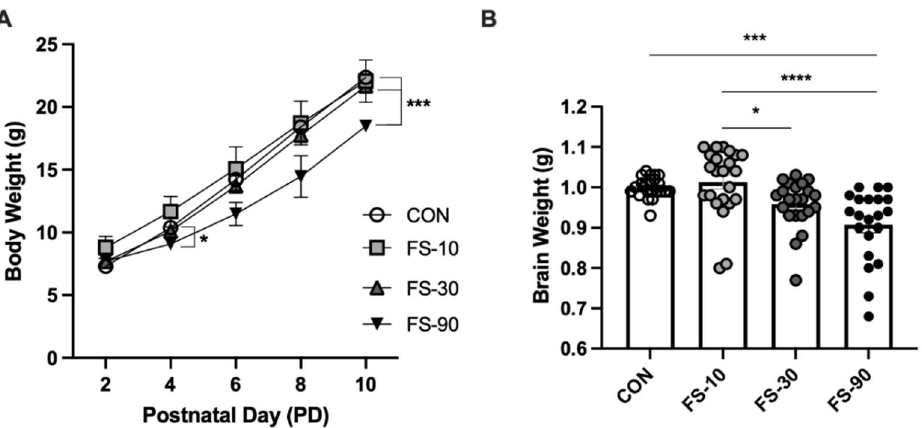
Figure 1. Growth and development are disrupted by excess ferrous sulfate (FS) iron supplementation in pre-weanling rats. ( A ) Postnatal growth was impaired in FS-90 supplemented animals; postnatal day (PD) 2–10. Body weight of pups (n = 21–24/group, 3 litters/group) was measured every two days (means ± SEM). ( B ) Brain weight at PD 10 was reduced the in FS-90 group vs. CON. Biological replicates (n = 21–24/group, 3 litters/group) are shown as individual data points with mean ± SEM. Vehicle control (CON); ferrous sulfate (FS)-10 (10 mg iron/kg BW); FS-30 (30 mg iron/kg BW); FS-90 (90 mg iron/kg BW). p -value summary: *, p < 0.05; ***, p < 0.001; ****, p < 0.0001. When stratified by sex, BW at PD 10 was lower only in FS-90 males compared to FS-10 and FS-30 males, an effect that was sex-specific (Figure S1A,B). Similarly, brain weight of FS-90 supplemented males but not females was lower than CON and FS-10 males (Figure